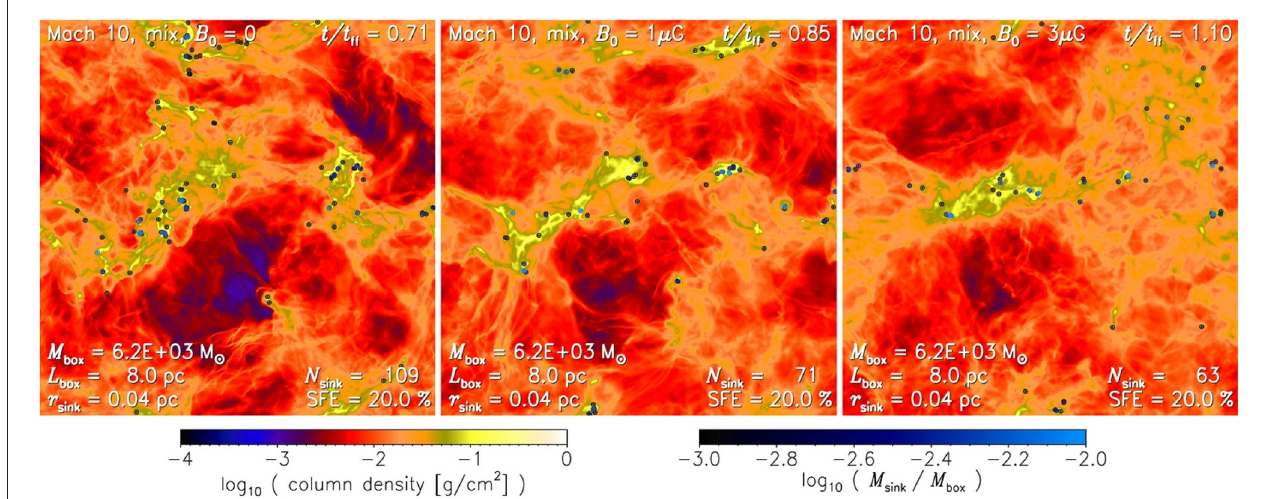
FIGURE 1 | Density projections in three simulations of self-gravitating MHD turbulence from Federrath and Klessen (2012). Each simulation takes place in a periodic box 8 pc on a side, initially containing 6,200 M of isothermal gas with sound speed c s 0.2 km s − 1 , driven with a mix of solenoidal and compressive turbulent = ⊙ modes at a sonic Mach number M 10. The three simulations were initialized with uniform magnetic fields with field strength B 0, 1 µ G, and 3 µ G (left to right); = = once the turbulence reaches steady state, the corresponding Alfvén Mach numbers are M A , 13, and 2.7. Points show the locations of sink particles, with color = ∞ indicating mass. All three simulations have been run to the point where 20% of the initial gas mass has converted to stars, but they have taken different lengths of time to reach this